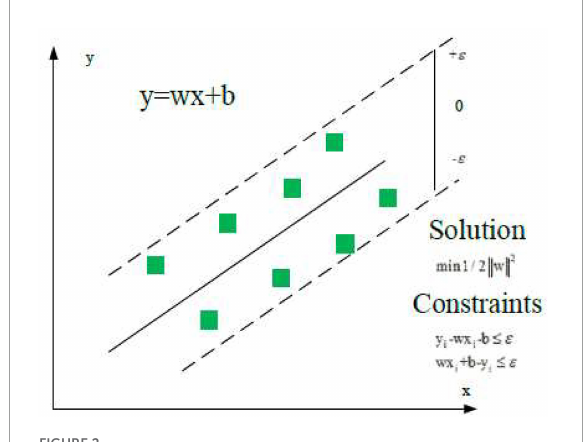
FIGURE2 Schematic diagram of support vector regression (SVR) model.